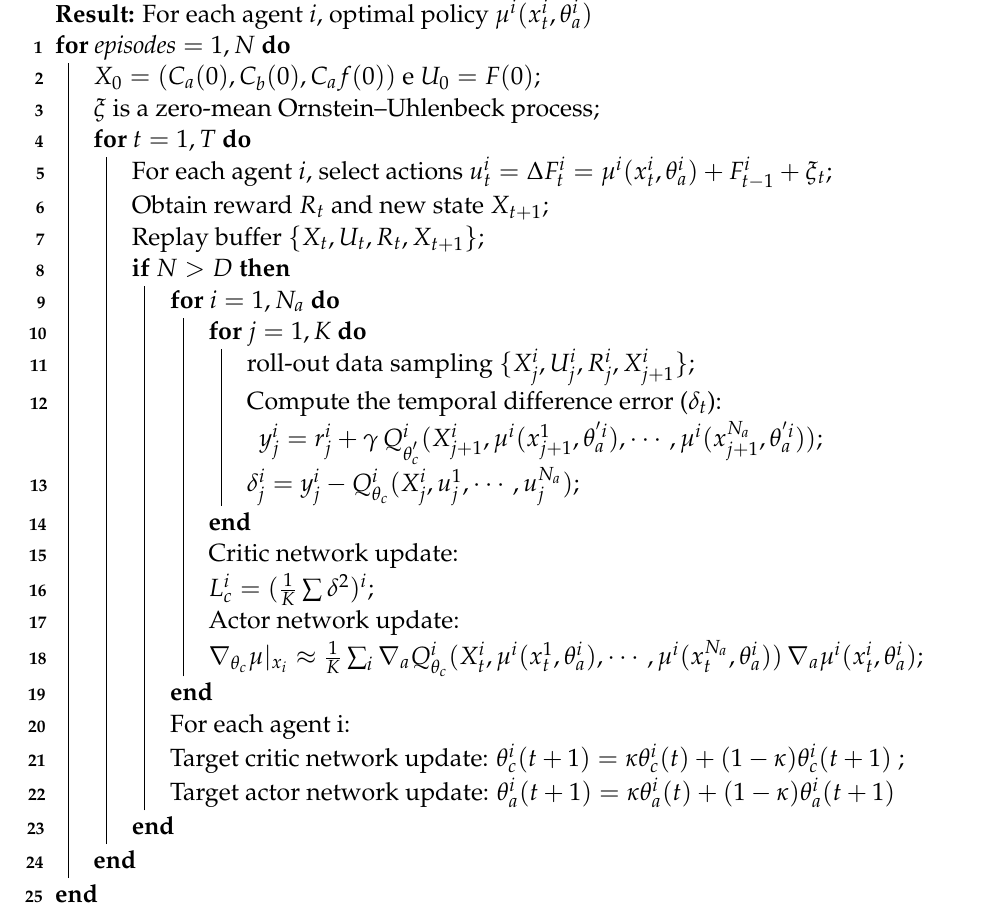
Algorithm 1: MADDPG